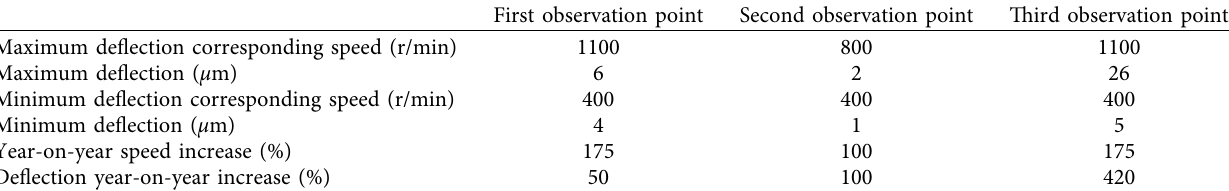
Table 14: Data summary of span-suspension ratio of 1:1.